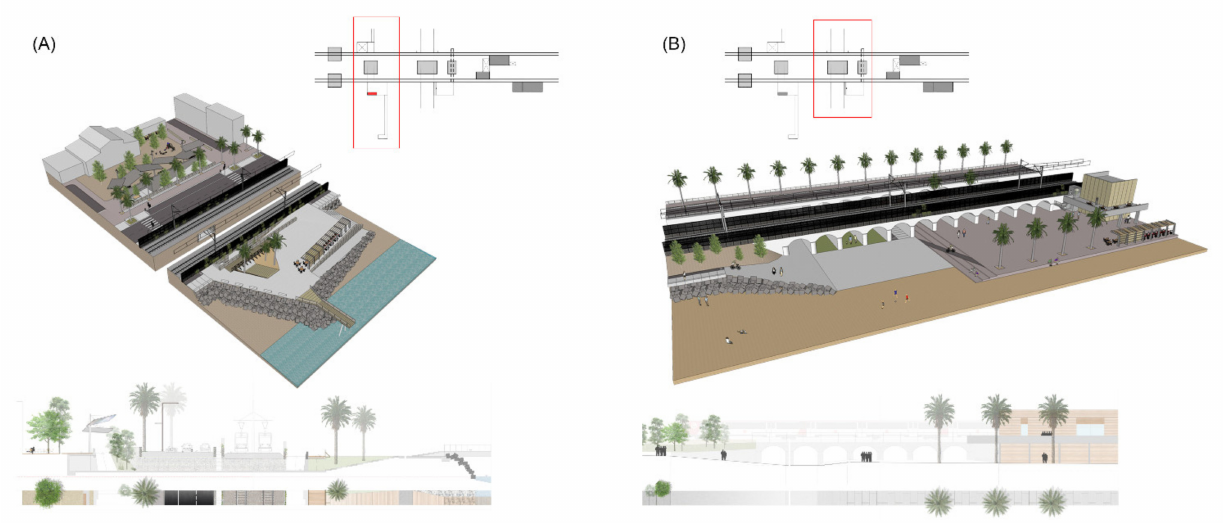
Figure 16. Standardized solutions for crossing typologies (Source: authors’ own). ( A ) Non-floodable crossing, both urban and maritime. ( B ) Floodable crossing, both urban and